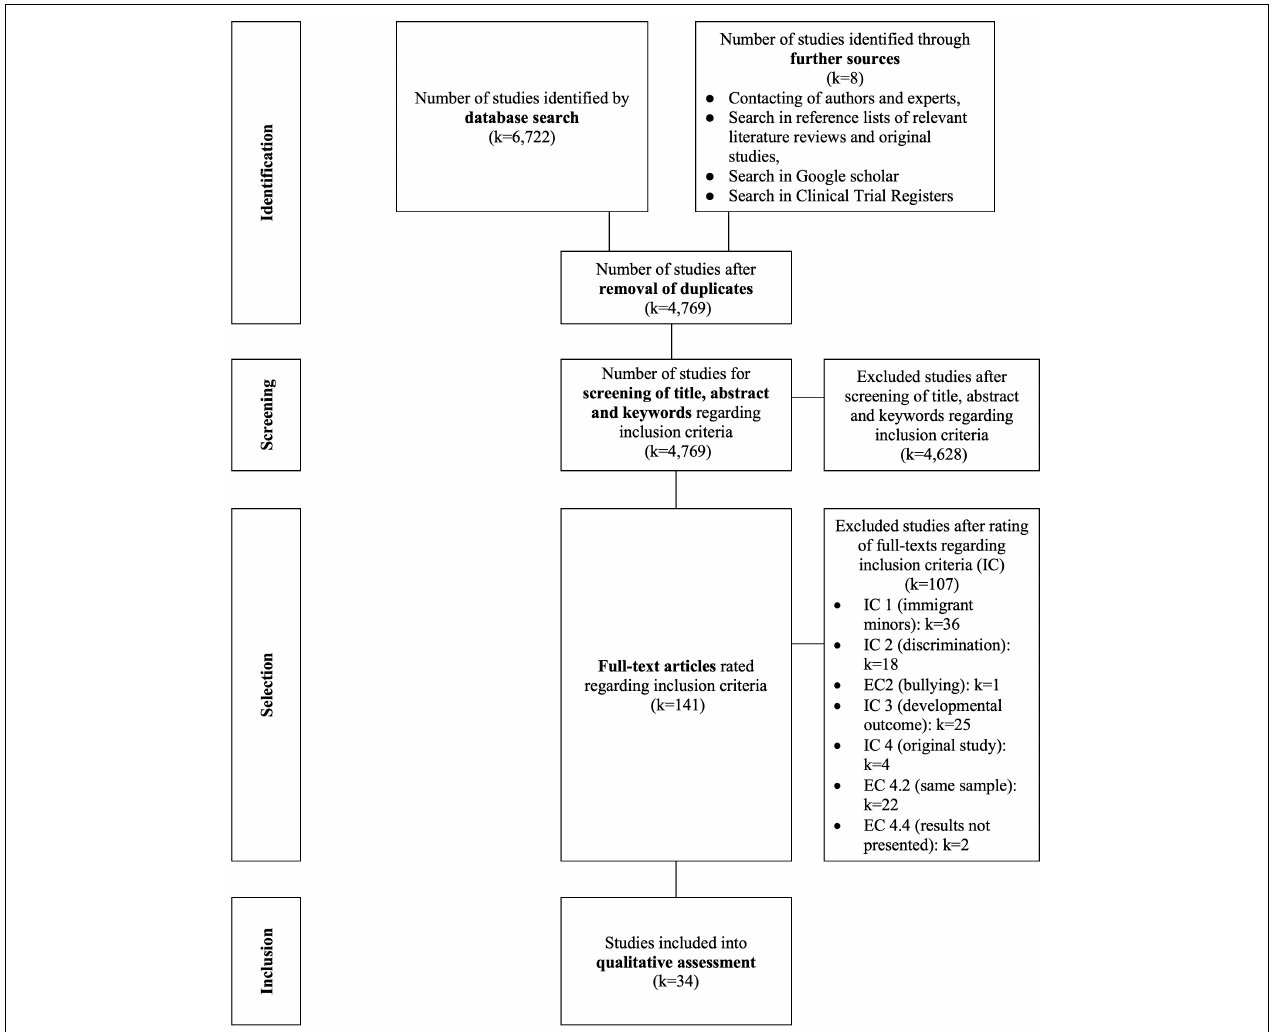
FIGURE 2 | PRISMA-Flow-Diagram for the presentation of the study selection process according to Moher et al. (2009).